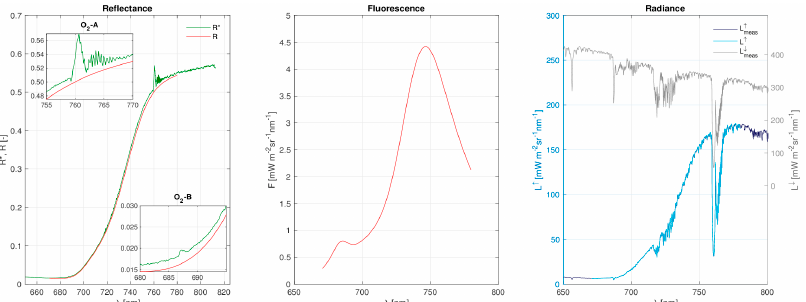
Figure 10. Retrieval of full F spectrum from FLOX: ( left ) apparent reflectance ( dark green ) and retrieved reflectance ( light green ); ( middle ) full F spectrum; ( right ) measured ( dark blue ) and modeled ( light blue ) canopy upwelling radiance and downwelling radiance ( gray